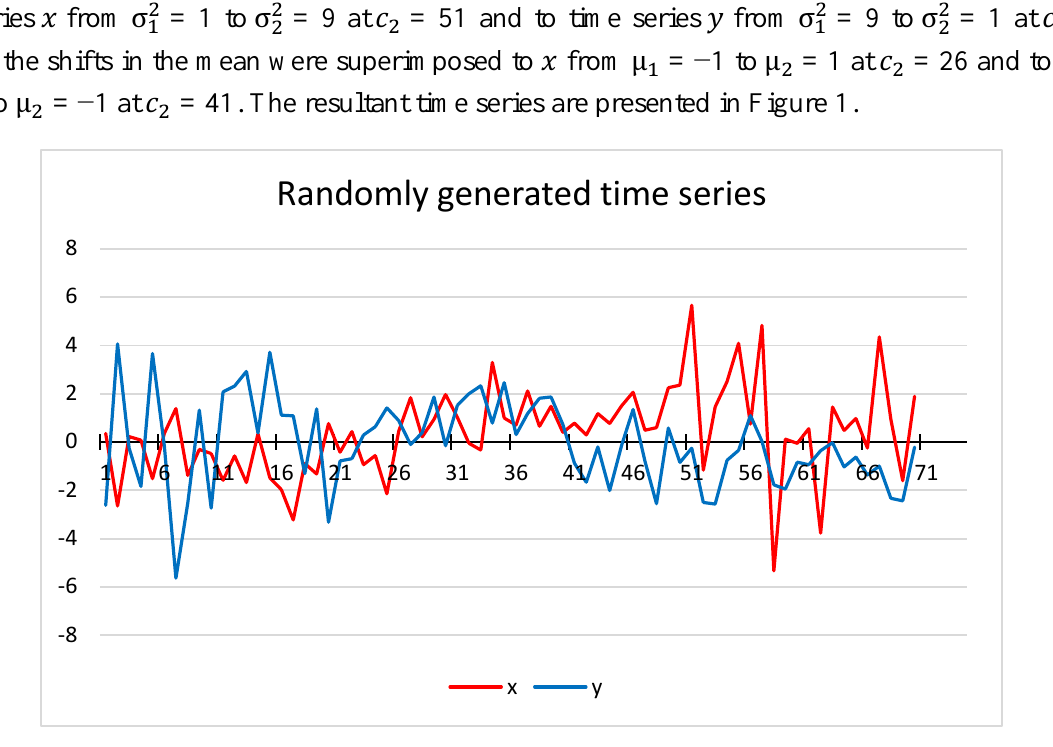
Figure 1. Randomly generated time series with shifts in the correlation coefficient, variance and mean as described in the